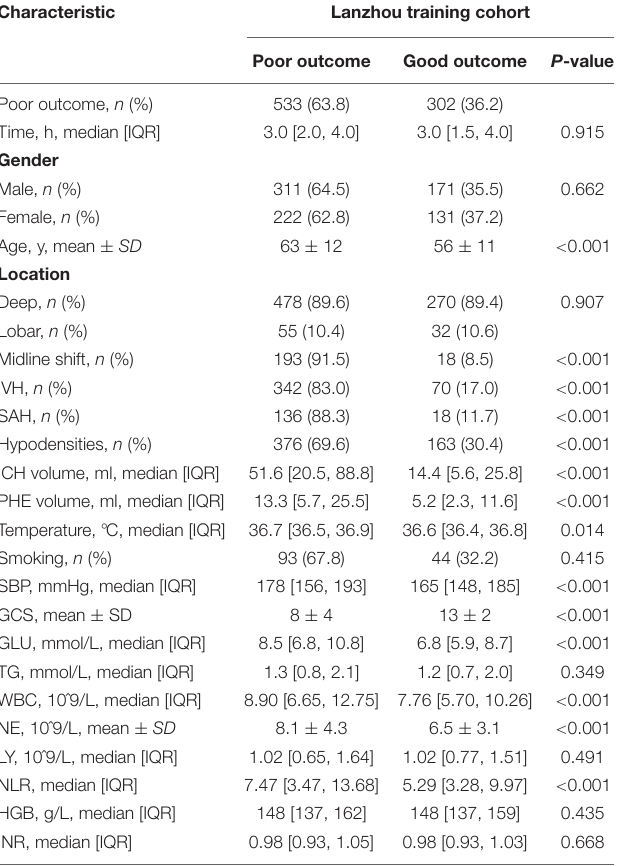
TABLE 2 | Univariate analysis for poor outcome in the training cohort. Characteristic